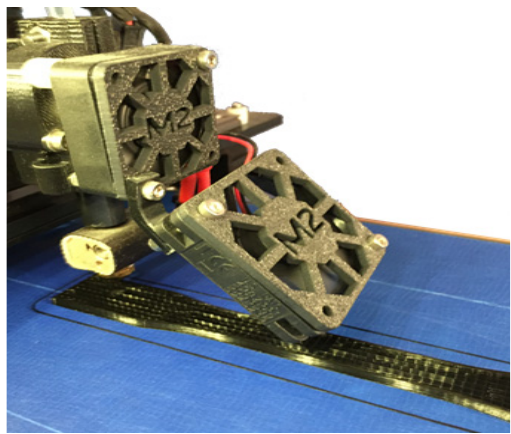
Figure 3. Various infills of Repetier-Host’s 3D previewer from top to bottom: rectangular, diamond, honeycomb (15% infill), and solid (100% infill).